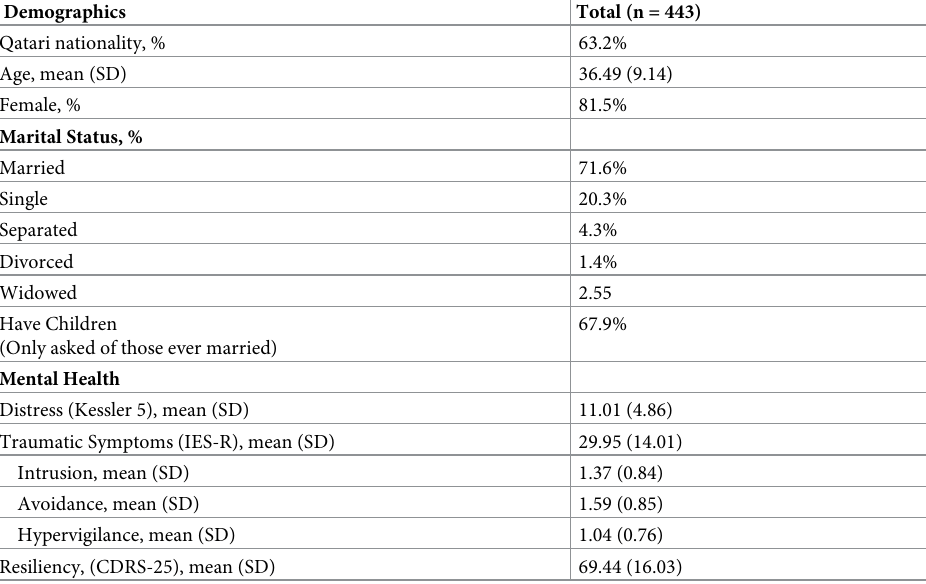
Table 1. Sample characteristics. Sample characteristics of the entire sample including demographics, marital status, and mental health symptoms.